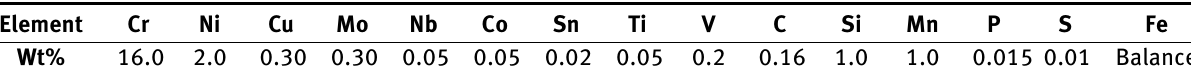
Table 1: Chemical composition of AISI 431 martensitic stainless steel. Element Cr Ni Cu Mo Nb Co Sn Ti V C Si Mn P S Fe